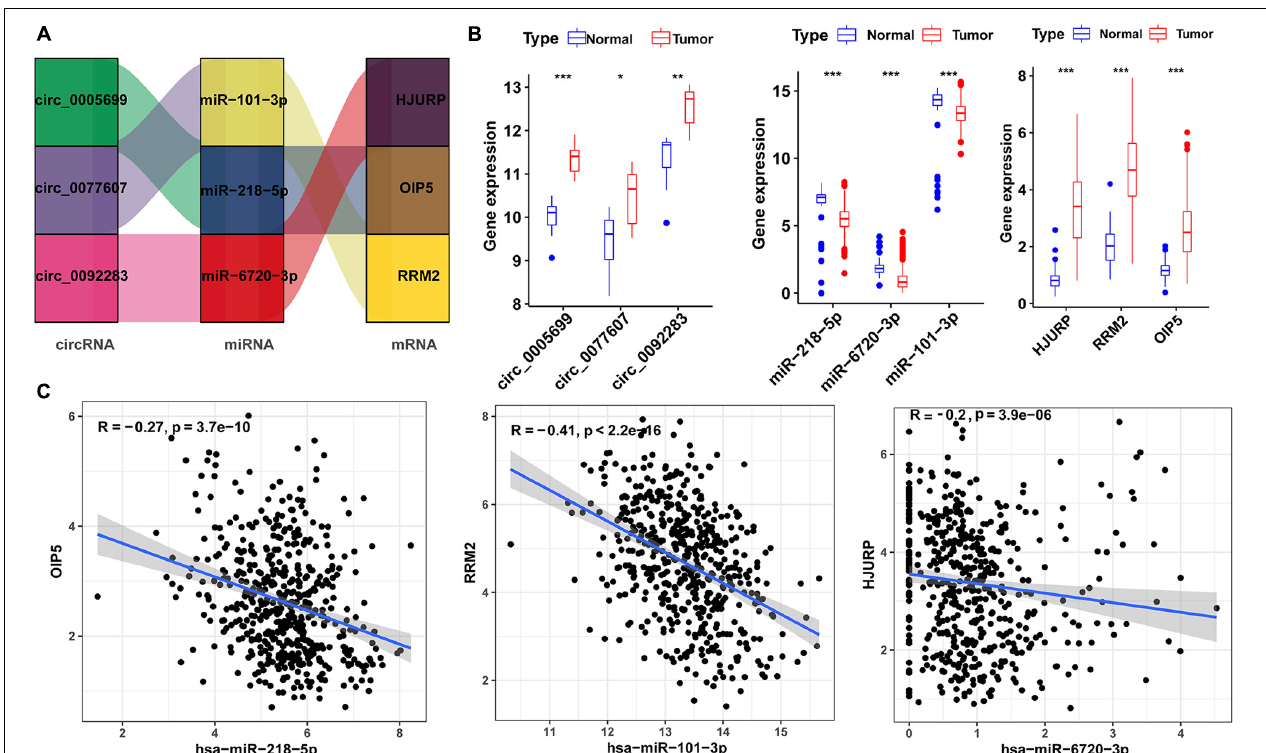
FIGURE 5 | Risk score-related regulatory subnetwork. (A) The ceRNA subnetwork associated with risk score. (B) Expression level of circRNAs, miRNAs [log2(TPM)], and mRNA [log2(TPM)] in LUAD and normal samples (* p < 0.05; ** p < 0.01; *** p < 0.001). (C) Coexpression analysis of miRNA-mRNA pairs based on TCGA data. LUAD, lung adenocarcinoma; ceRNA, competitive endogenous RNA. OS, overall